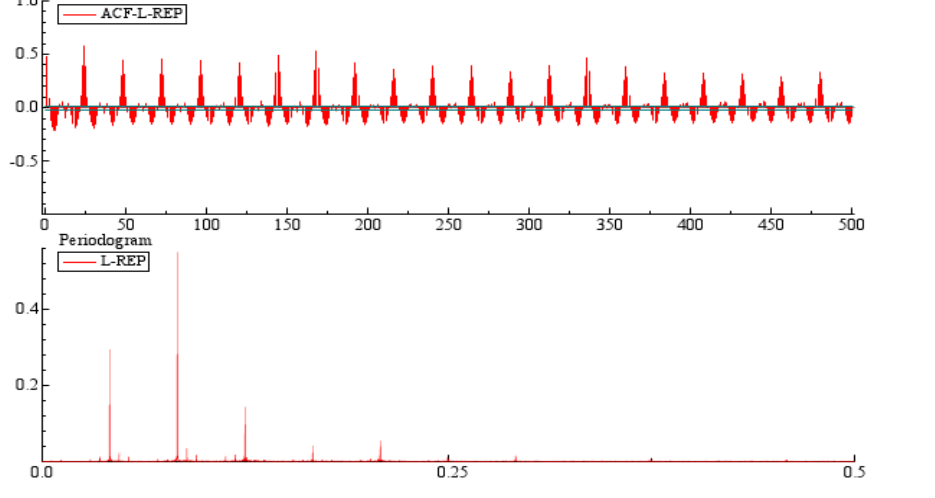
Figure 3. Polish L-REP ACF and Periodogram. Table 2. Results of GPH and LW tests in the conditional